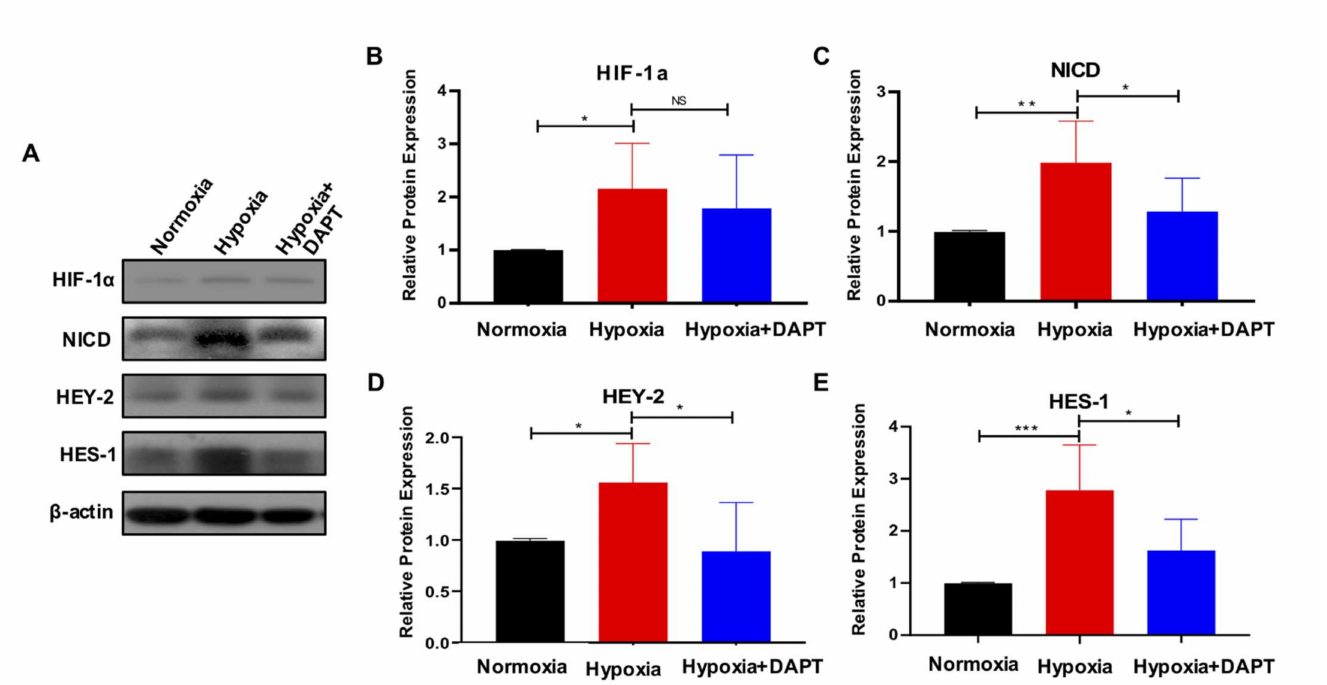
Figure 6. Upregulation of Notch activity in eMSC cultured under hypoxia is reversed by DAPT. ( A ) Representative Western blotting images of HIF-1 α and Notch-related proteins expression in eMSC cultured under different conditions. ( B – E ) Relative quantitative analysis of HIF-1 α and Notch-related proteins expression in eMSC cultured under different conditions ( n = 6). Results are presented as mean ± SD; * p < 0.05; ** p < 0.01; *** p < 0.001. Abbreviation: eMSC, endometrial mesenchymal stem-like